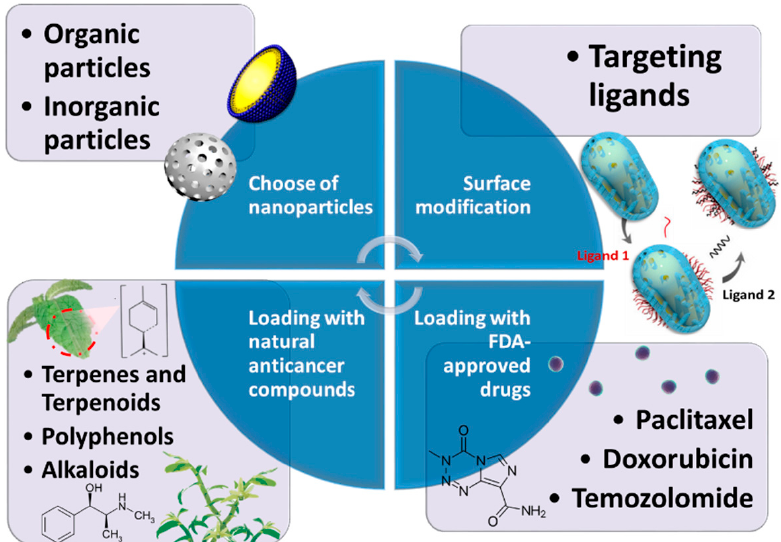
Figure 6. Schematic illustration of the nanocomposites combined with chemotherapy. The drug delivery system for GBM chemotherapy can be optimized by the composition of nanoparticles, ligands, and medicine.